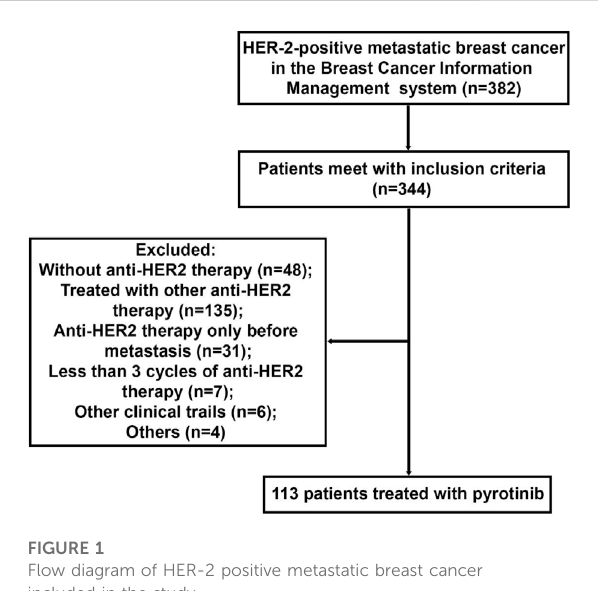
FIGURE 1 Flow diagram of HER-2 positive metastatic breast cancer included in the study.